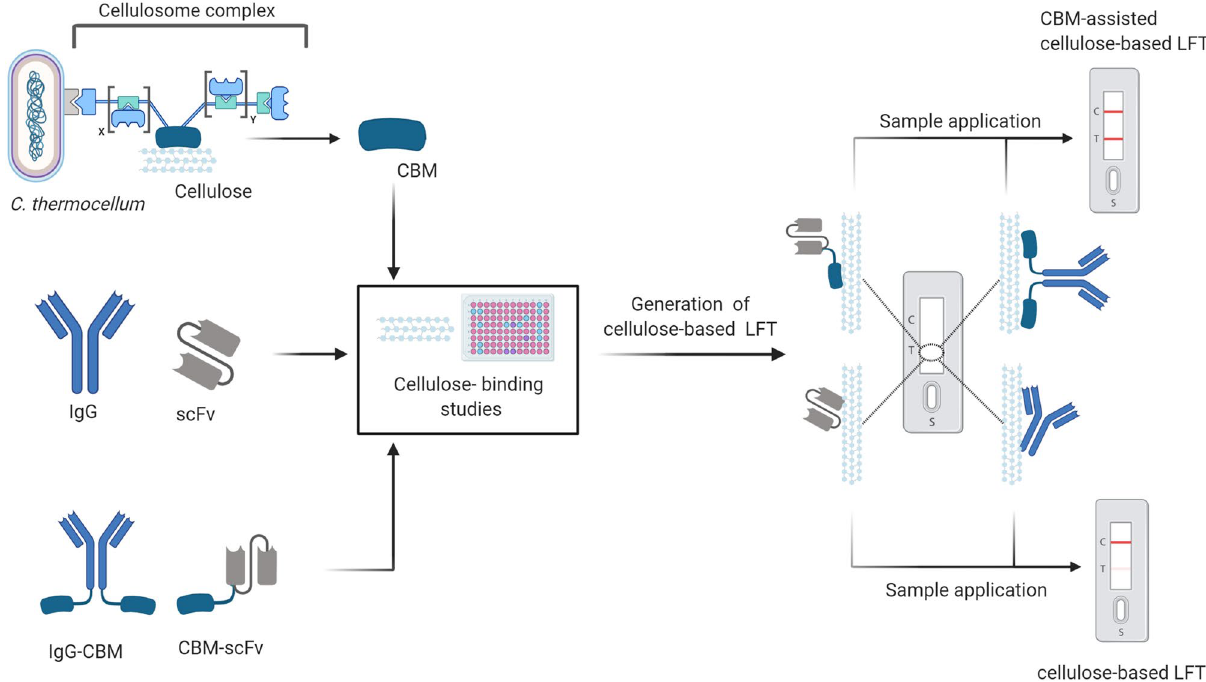
Figure 1. Workflow of the generation of carbohydrate-binding module-assisted lateral flow assays: The carbohydrate-binding module 3a of Clostridium thermocellum (CBM) was fused to different single chain variable Fragments (scFv) or to full-length antibodies (IgG). The resulting CBM-fusion proteins, as well as the non-fused CBM, scFv and full-length antibody were examined regarding their binding properties